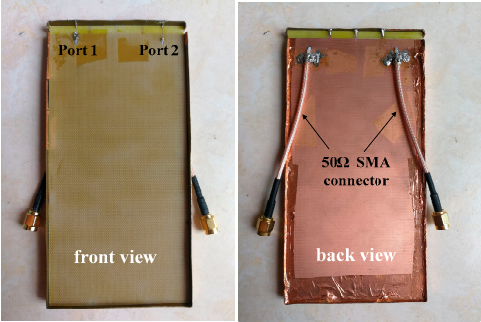
Figure 8. The photos of the fabricated dual antenna system.